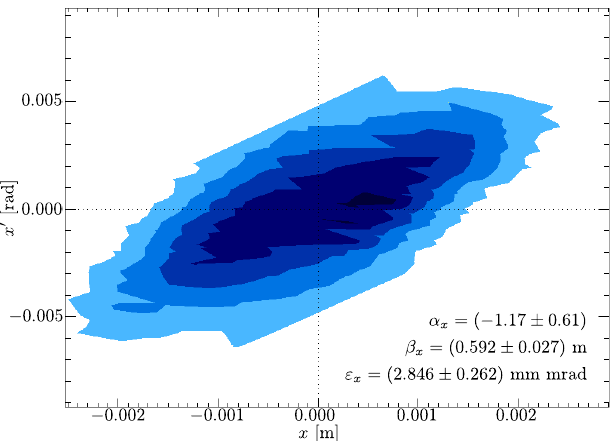
FIG. 6. (Color) Horizontal phase space density reconstruction from pinhole array data. The image and printed results were calculated using the data shown in Fig. 5.